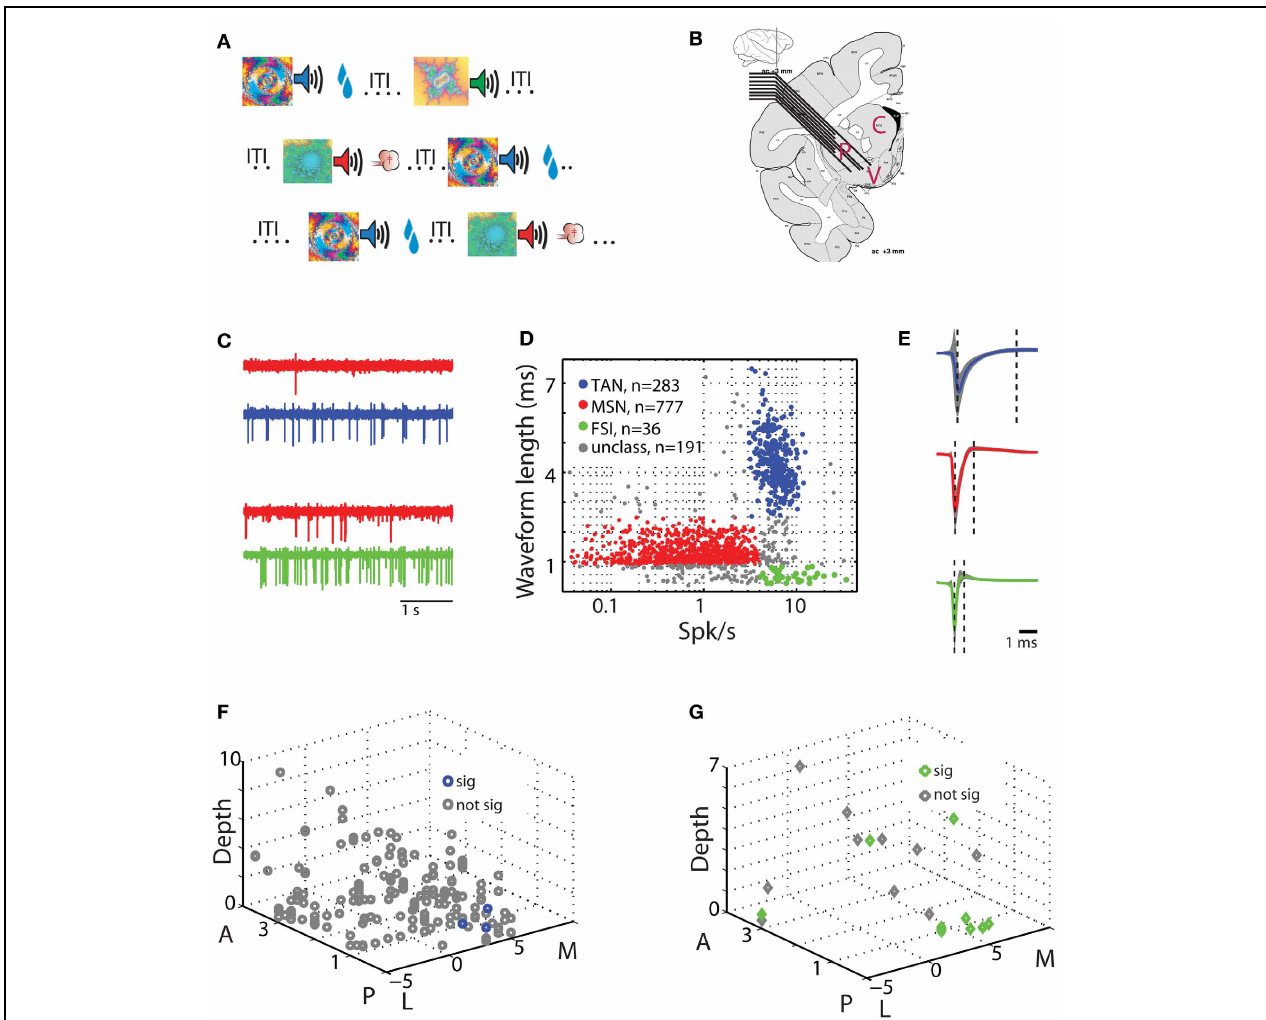
FIGURE 1 | Behavioral task and physiological recording methods. (A) Classical conditioning paradigm. Visual cues were presented for 2s and predicted the delivery of food (reward trials, upper row), air puff (aversive trials, third row), or only sound (neutral trials, second row). The trial outcome epoch was followed by a variable inter trial interval (ITI) of 5–6s. (B) Recording sites: a representative coronal section + 3mm from the anterior commissure [adapted from Martin and Bowden, 2000]. Two to eight electrodes were advanced separately into one or two of the three sub regions of the striatum. P for putamen, C for caudate, and V for ventral striatum. (C) An example of simultaneously recorded pairs of units from the putamen. Each row is a 4s analog trace of extracellular recording from a single electrode filtered between 300 and 6000Hz. First two rows are MSN (red) and TAN (blue) recorded simultaneously, second two rows are MSN (red) and FSI (green) recorded simultaneously. (D) Classification of striatal neuron subtypes. Each dot represents a single neuron colored according to